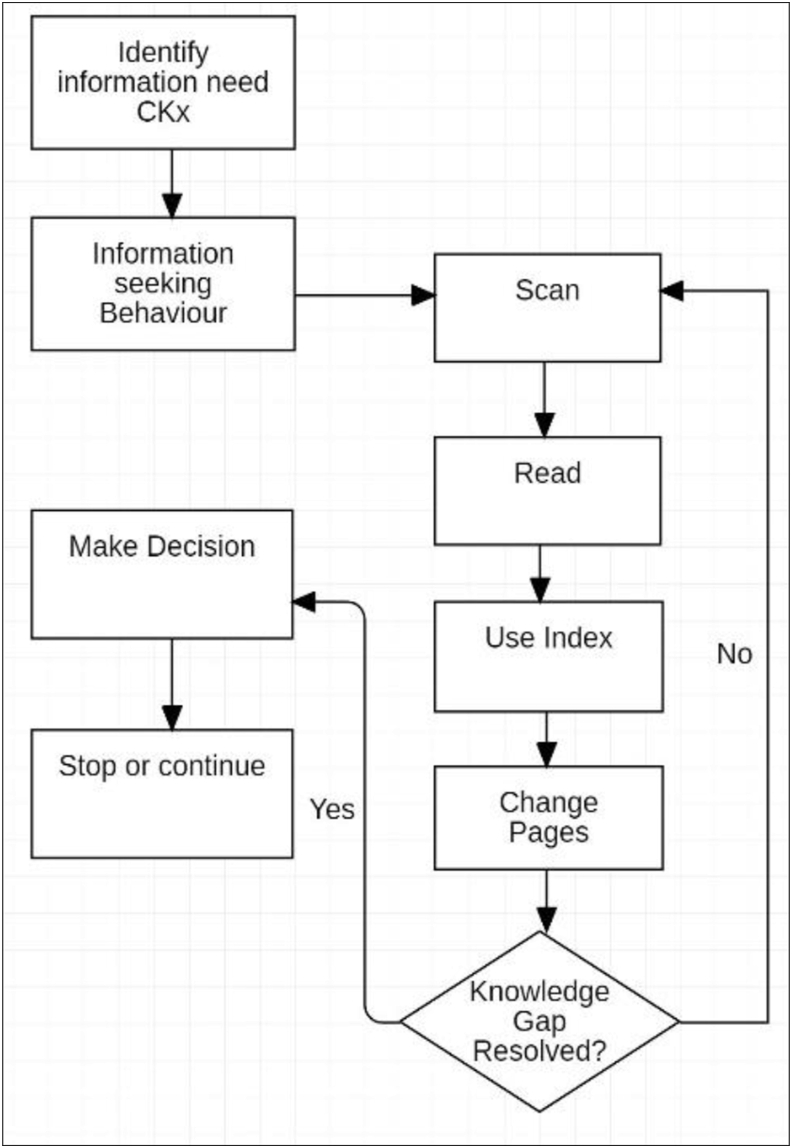
Decision process.